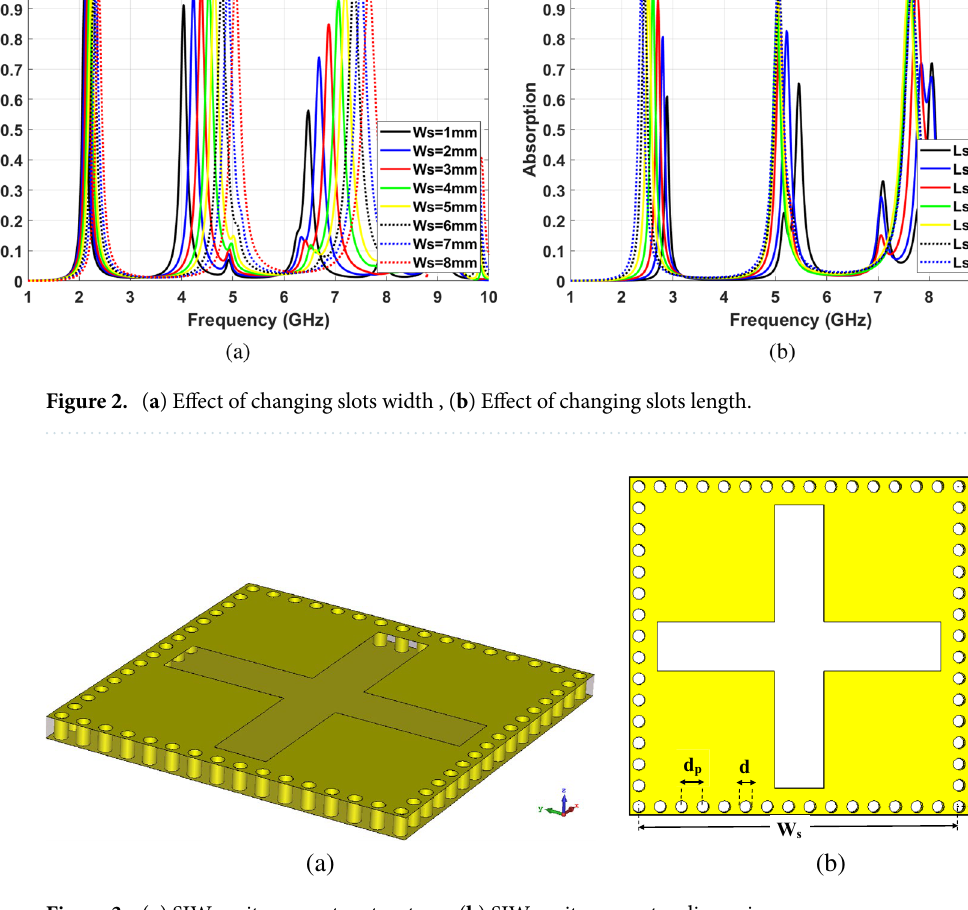
Figure 3. ( a ) SIW cavity resonator structure , ( b ) SIW cavity resonator